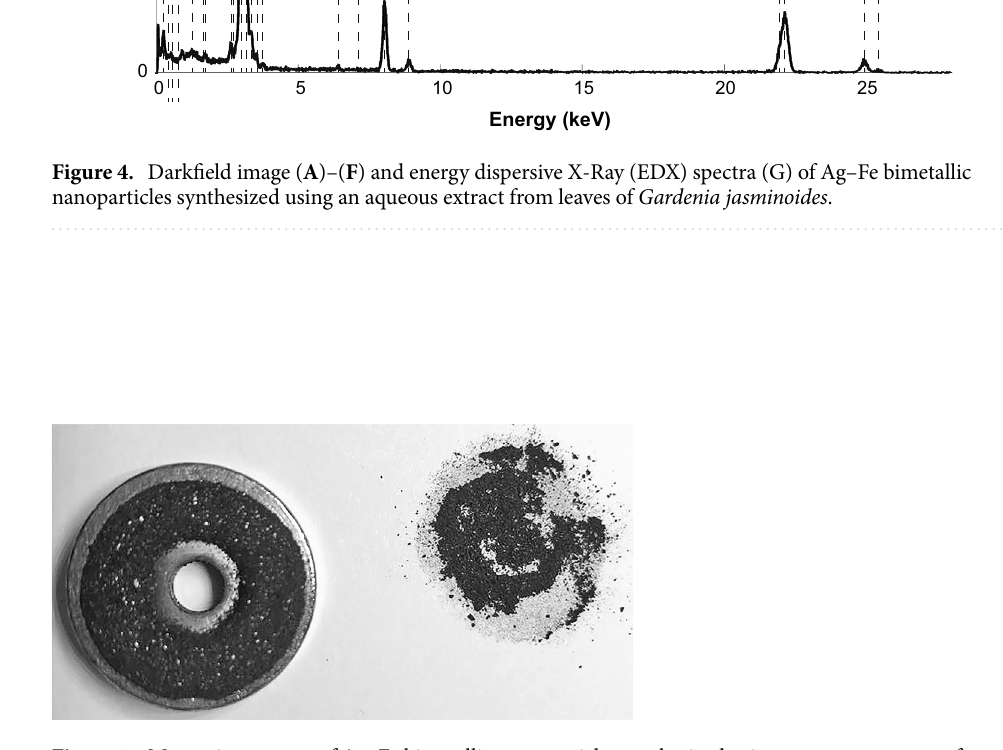
Figure 5. Magnetic property of Ag–Fe bimetallic nanoparticles synthesized using an aqueous extract from leaves of Gardenia jasminoides